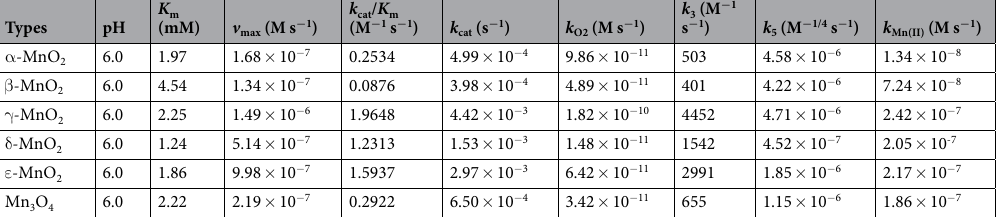
Table 1. Rate constants for the laccase-like reactions of different manganese oxide nanomaterials with ABTS as the substrate.